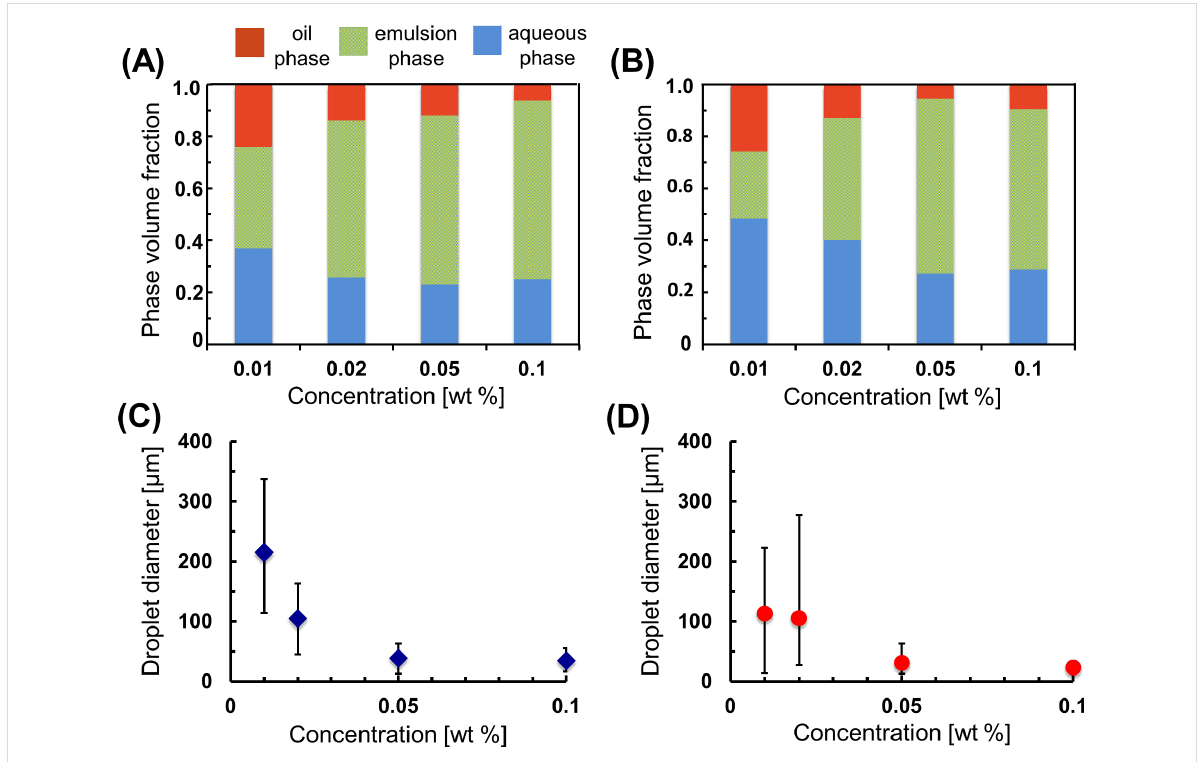
Figure 5: (A,B) Phase volume fractions and (C,D) droplet diameters of n -dodecane-(A) or toluene- (B) in-water emulsion stabilized by the DM- β -CD/ PDI nanogel at various nanogel